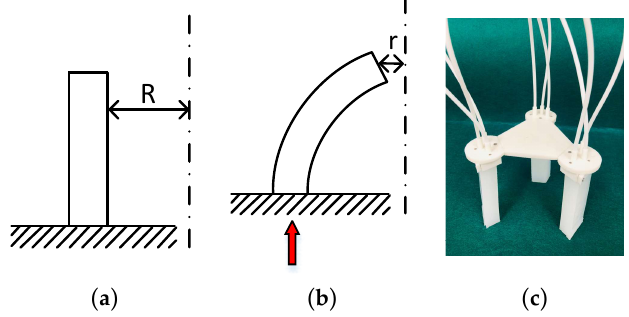
Figure 6. The gripper design; ( a ) initial position of a finger: The center of the palm is the dashed line; the maximum grasping size was R = 0.052 m. ( b ) Position of a pressurized finger; minimum grasping size r = 0.02 m. ( c ) The prototype: Fingers are separated by 0.09 m.